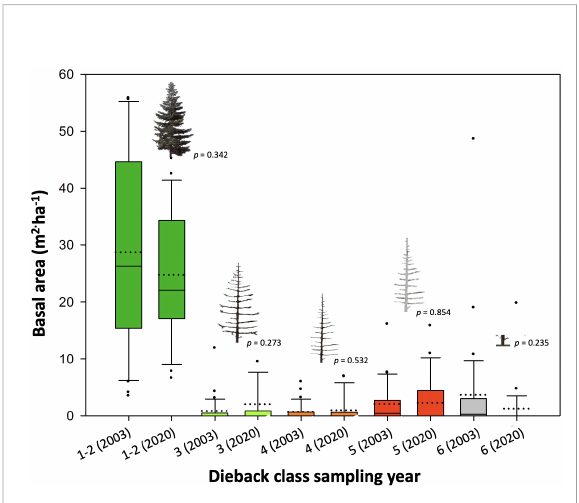
FIGURE 2 Total basal areas for the different tree classes, as obtained in the 2003 and 2020 fi eld surveys performed on thirty-one A. pinsapo stands. Alive (tree-class 1); declining (class 2); and dead trees (classes 3 to 6 ) were classi fi ed according to canopy dieback (defoliation, needles brownness) and bark/wood decay symptoms (see also Supplementary Figure 1). An ANOVA was performed to compare the basal areas between years within damage class. P -values are indicated for each comparison (see also Supplementary Table